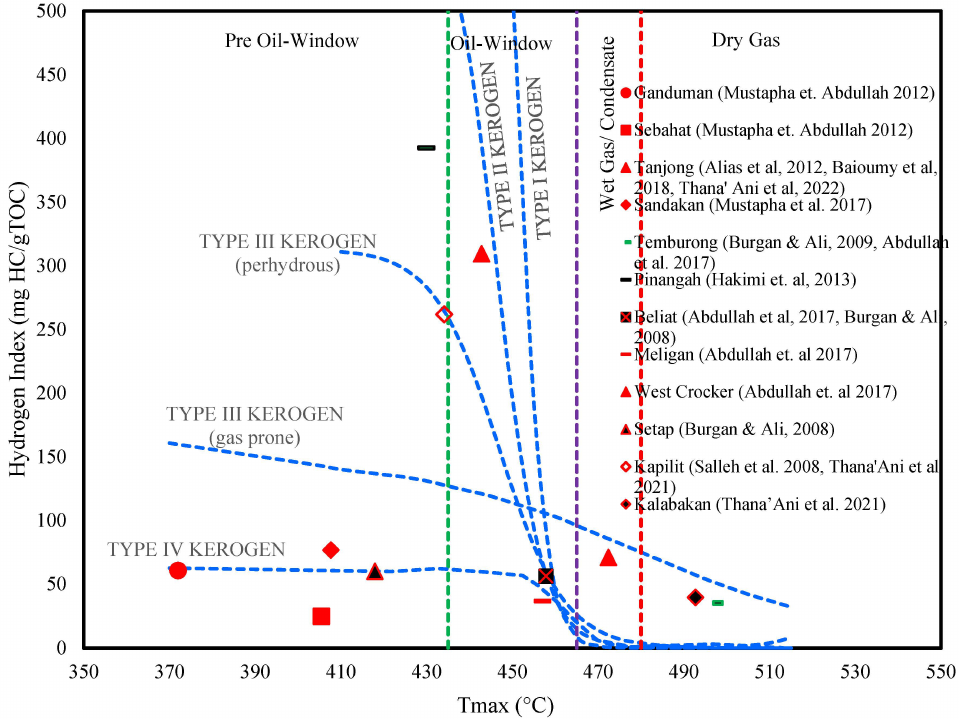
Figure 13. Tmax versus HI plot showing the level of kerogen maturity of formations in Sabah.